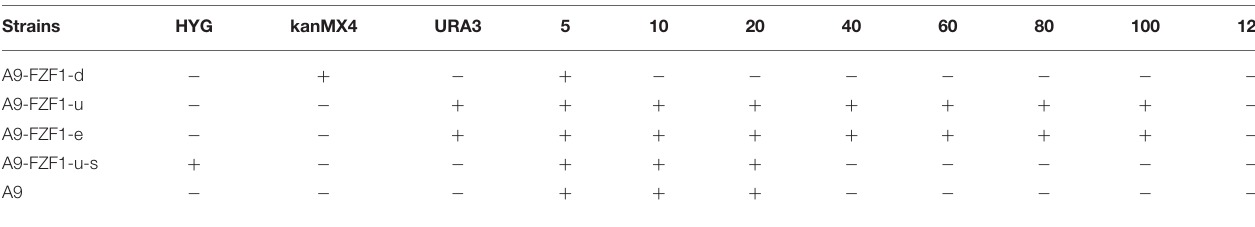
TABLE 2 | The genotype and sulfite resistance ability of different S. uvarum stains or transformations. Strains